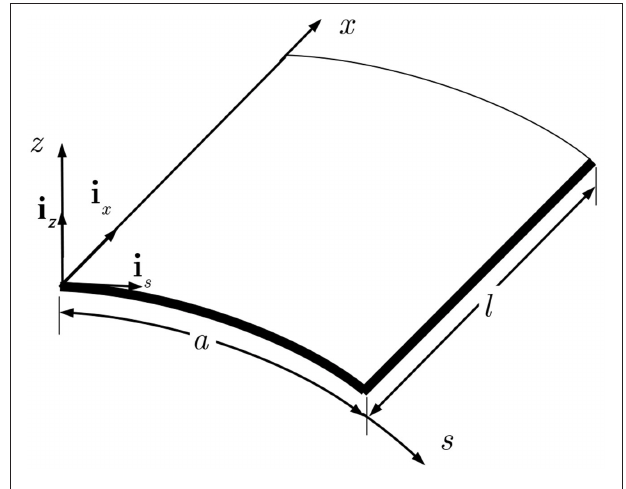
FIGURE 1 | Cylindrical